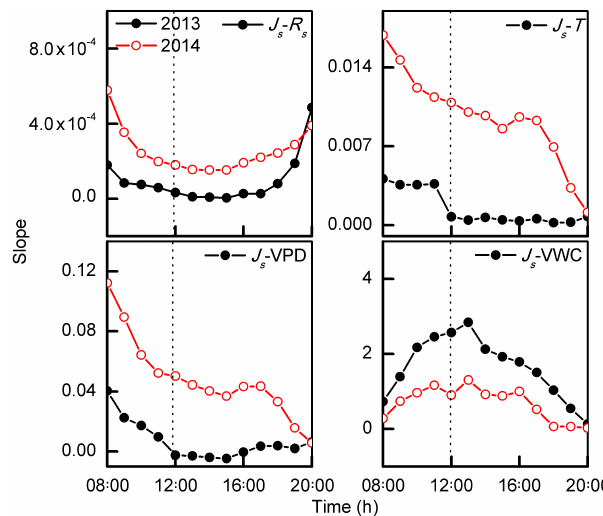
Figure 5. Regression slopes of linear fits between sap flow per leaf area ( J s ) in non-rainy days and shortwave radiation ( R s ), va- por pressure deficit (VPD), air temperature ( T ) , and volumetric soil water content (VWC) between 08:00 and 20:00 during the mid- growing season of 1 June to 31 August for 2013 and